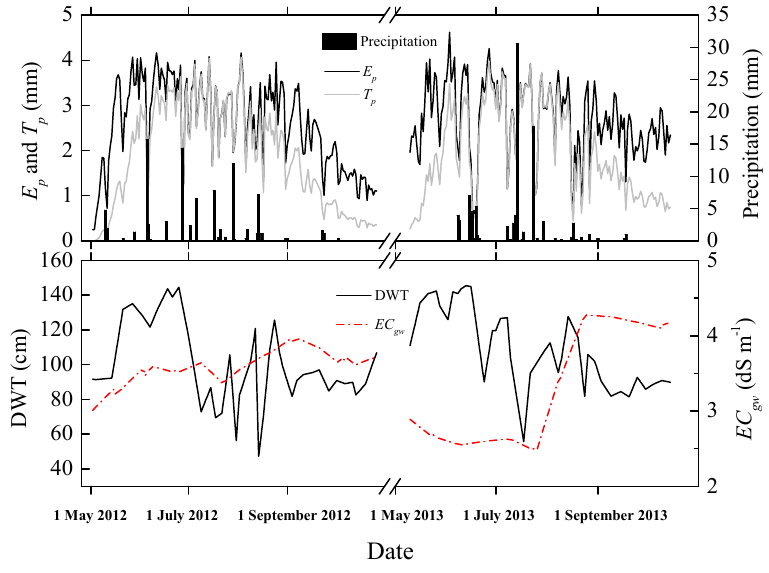
Figure 2. Dynamics of potential evapotranspiration, precipitation, depth to water table (DWT) and groundwater electric conductivity (EC gw